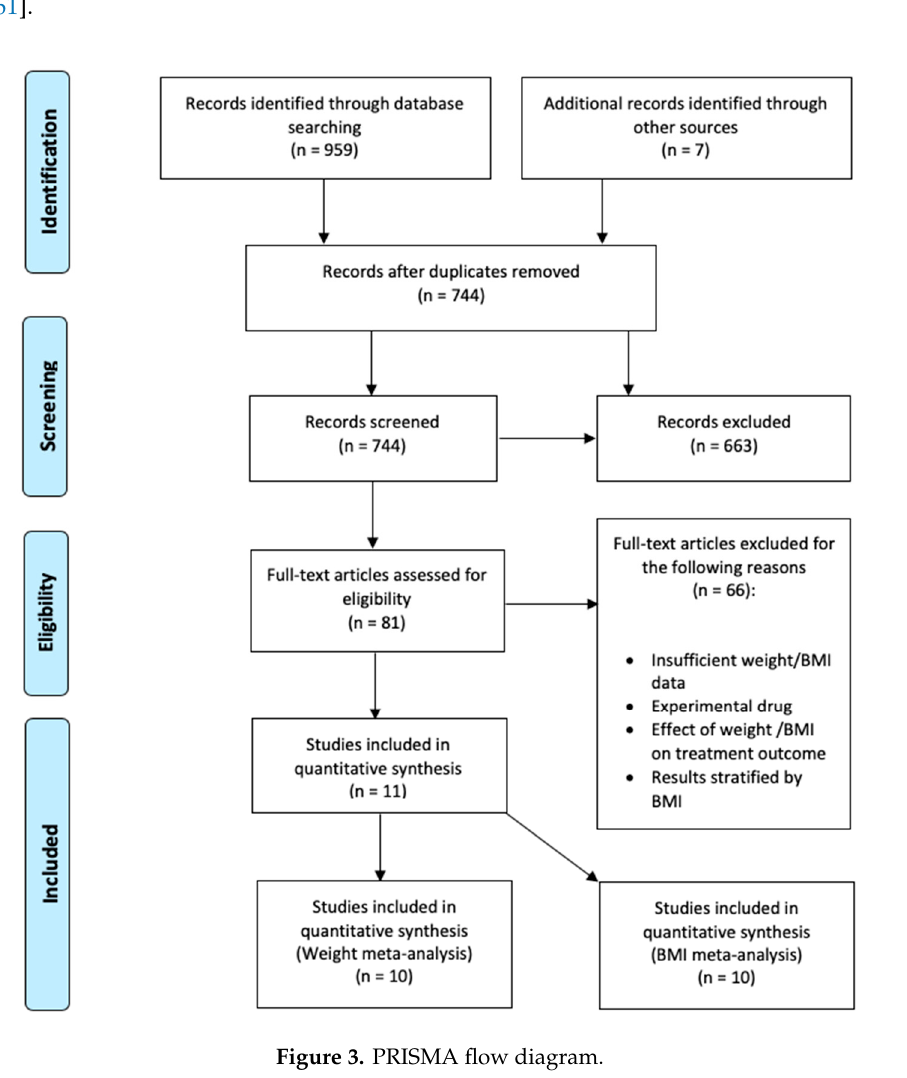
Figure 3. PRISMA flow diagram.